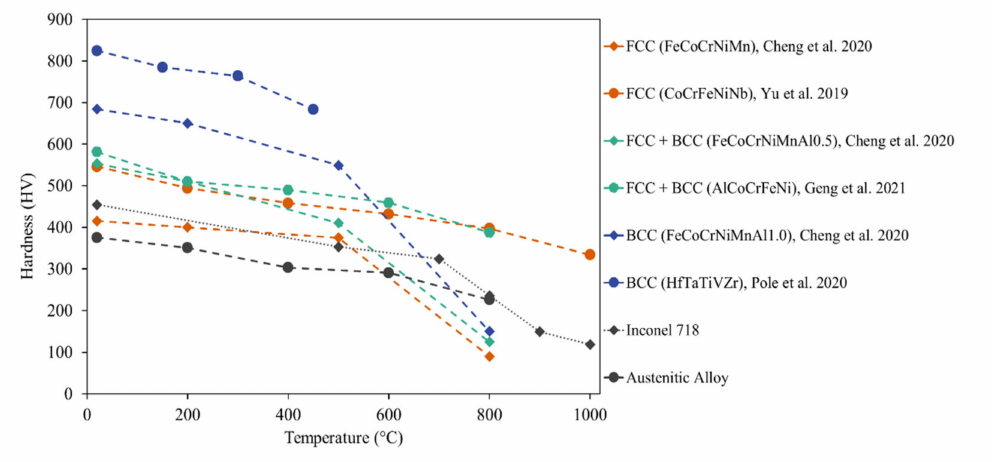
Figure 11. Hardness variation of HEAs over